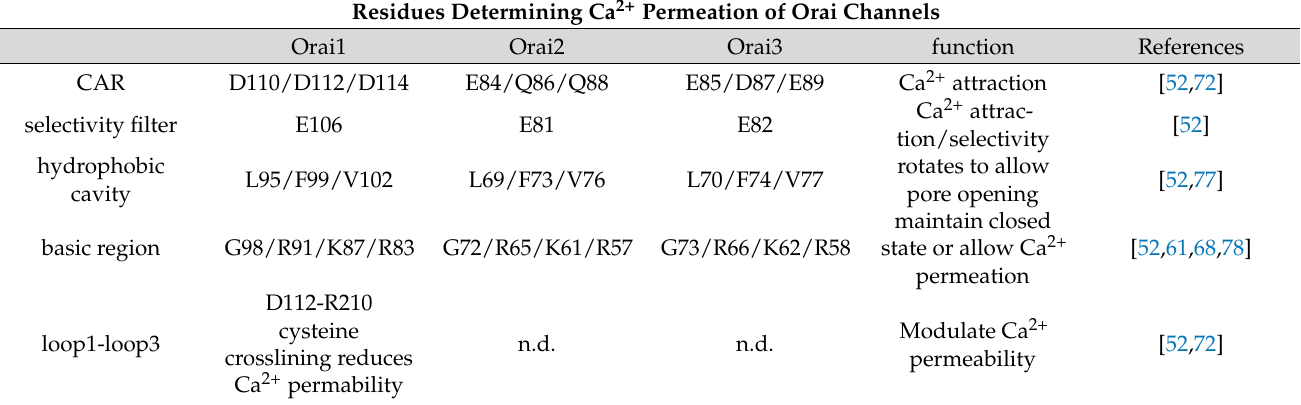
Table 2. Isoform-specific alterations of regions determining Ca 2+ permeation through the Orai